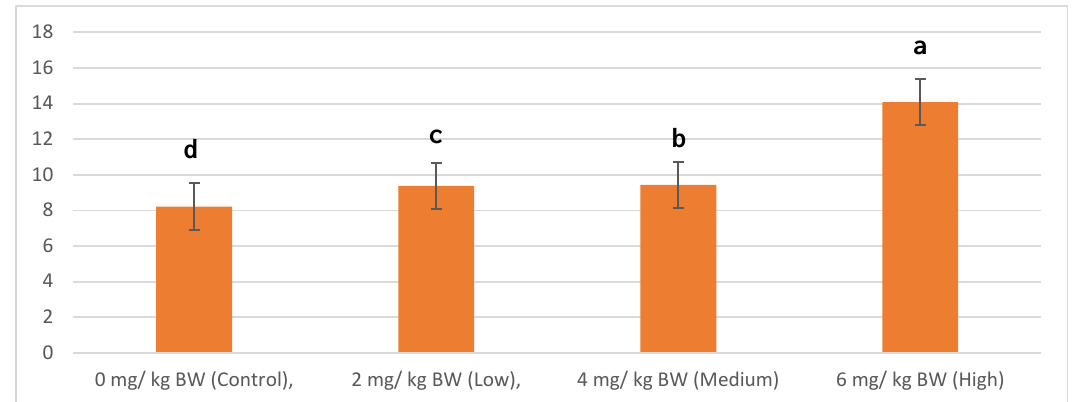
Figure 2. The fiber diameter (mm) of longissimus thoracis et lumborum muscle of goats supplemented with naturally produced lovastatin. a,b,c,d Score within a row with different superscripts differ significantly at p < 0.05.